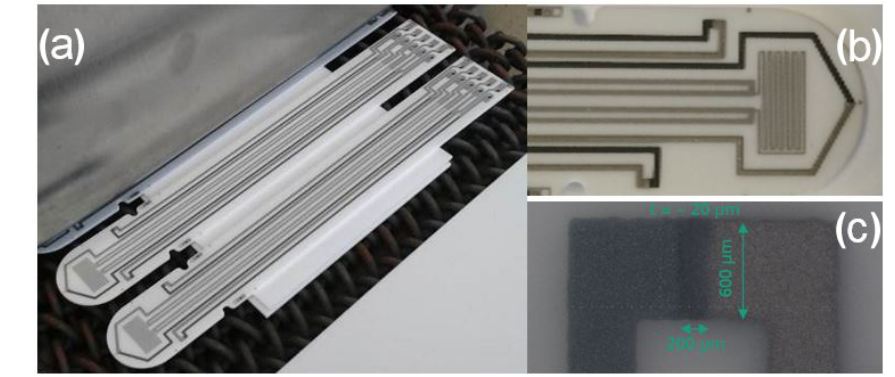
Figure 1. (a) Firing of thick-film thermocouples on alumina substrates, (b) sensor layout consisting of three thermocouples and one reference PT100 platinum resistance thermometer and (c) microscope images of the miniaturized thick-film thermojunction on a planar substrate.